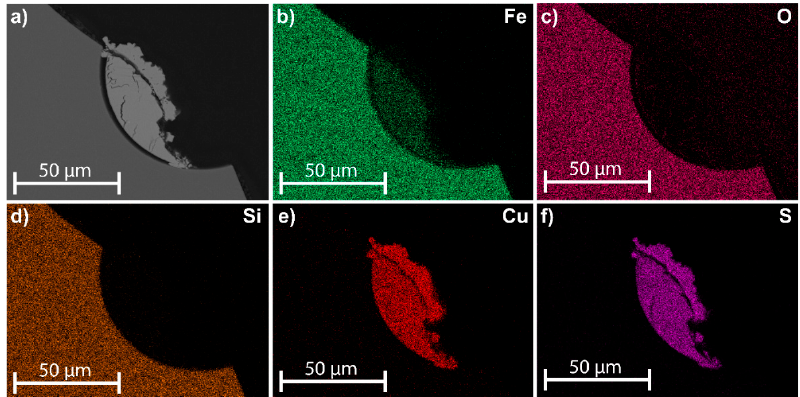
Figure 7. EDS mapping of a typical cross-section of phases from samples (F06) after dynamic leaching. ( a ) SEM image; distribution of ( b ) Fe, ( c ) O, ( d ) Si, ( e ) Cu, and ( f ) S.